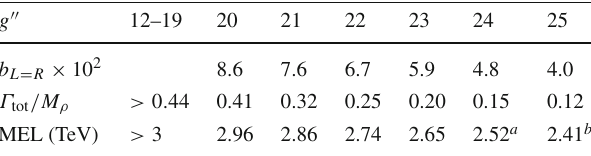
a The mass is also not excluded within ( 1 . 24 ; 1 . 30 ) TeV Table 7 The updated smallest tBESS resonance mass exclusion limits (MEL) within the interval | b L = R | ≤ 1 assuming b L = R ≡ b L = b R and p = 1 for various values of g (cid:2)(cid:2) . The second and third rows contain, respectively, the values of b L = R and of the resonance fatness Γ tot / M ρ that correspond to the quoted mass exclusion limit g (cid:2)(cid:2)